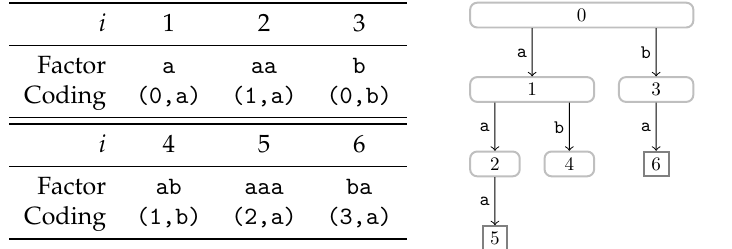
Figure 7. The LZ78 factorization and its LZ trie for the text T = aaababaaaba . The x th factor is the concatenation of the edge labels of the path from the root to the node labeled with x . Its referred index is the label of its